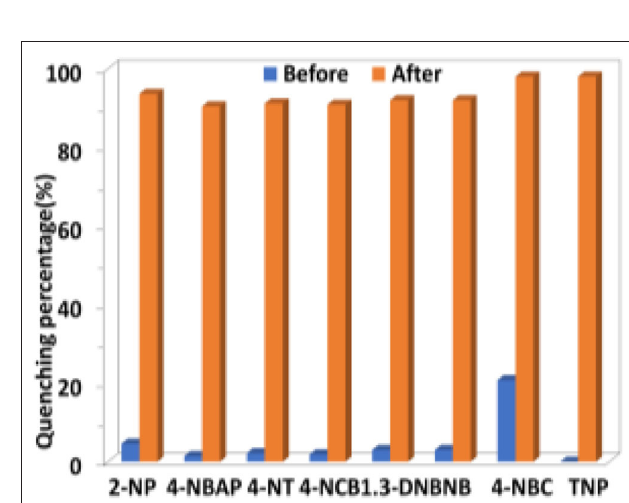
FIGURE 9 | The luminescence quenching percentages of 1 (0.5 µ M) before and after the addition of TNP (10 µ M) in the presence of other explosives (10 µ M) in CH 3